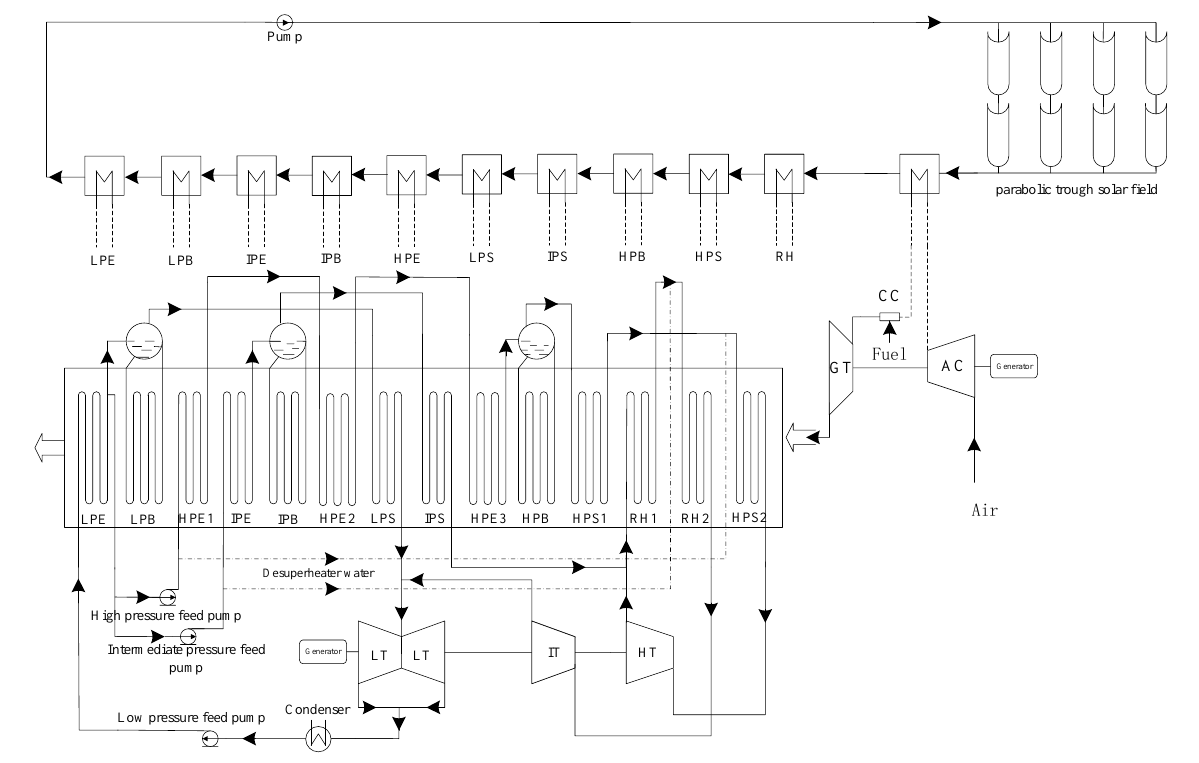
Figure 1. Flow diagram of a common integrated solar combined cycle (ISCC) system.